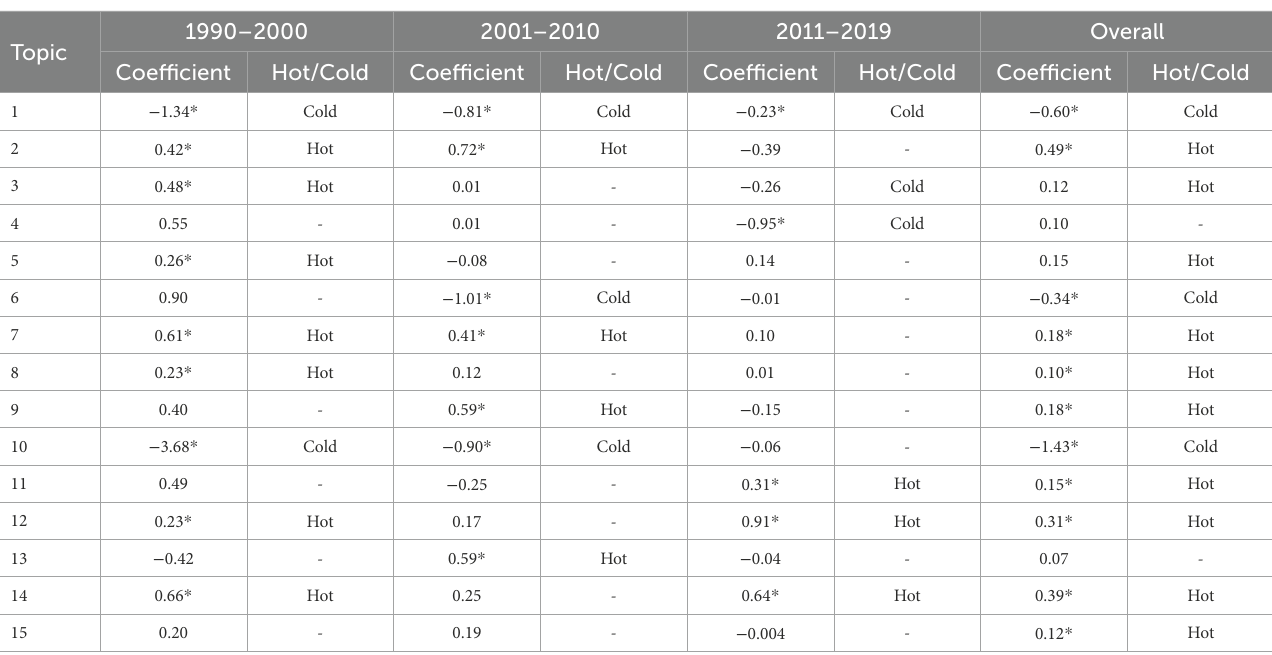
TABLE 4 Hot/Cold